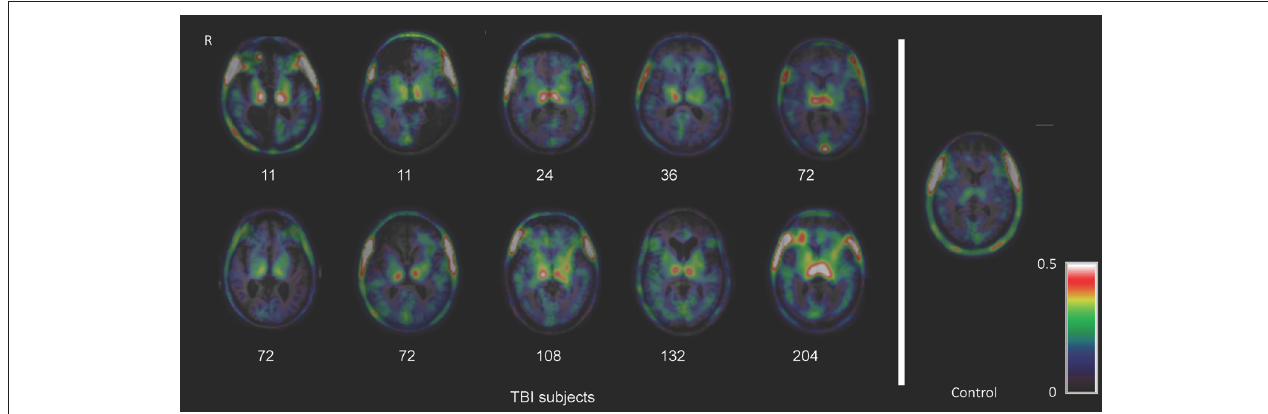
FIGURE 2 | Imaging of chronic microglial activation after TBI. Images of [11C]PK11195 PET images are shown superimposed on the T1 MRI scan at the level of the thalamus for 10 TBI patients, 11 months to 17 years after injury, and a representative control participant. Numbers indicate time since injury (months). R = right. The figure has been reproduced with permission of the copyright holder (Ramlackhansingh et al., 2011).